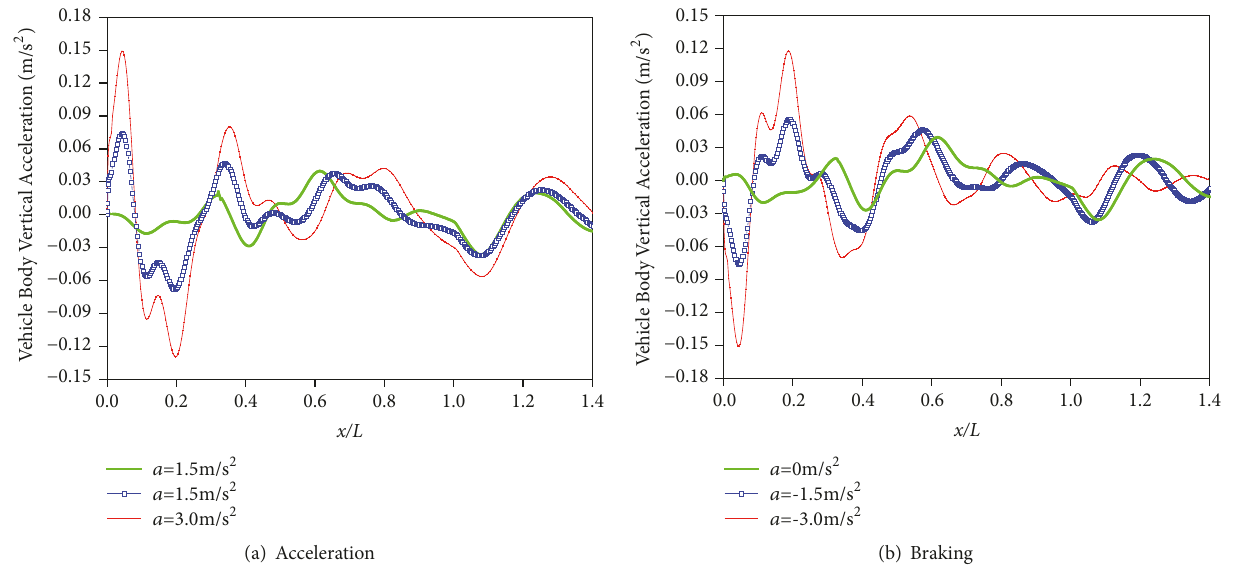
Figure 12: Vertical acceleration of vehicle body during varied vehicle speed.